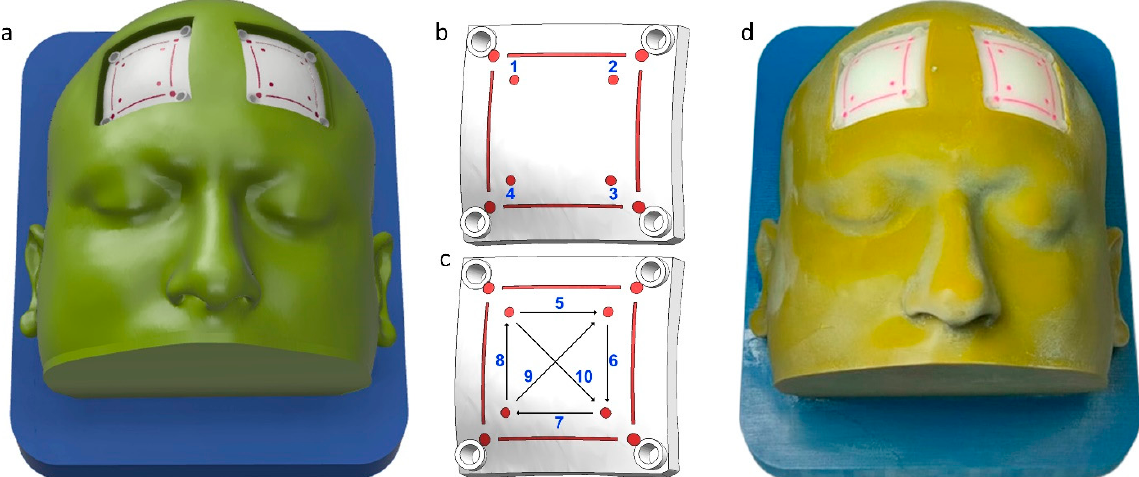
Figure 1. Craniotomy simulator with removable flaps for drilling activity. ( a ) CAD model, ( b ) 1–4 burr hole drilling activity, ( c ) 5–8 straight lines, and 9–10 diagonal line drilling activity, and ( d ) 3D printed prototype.